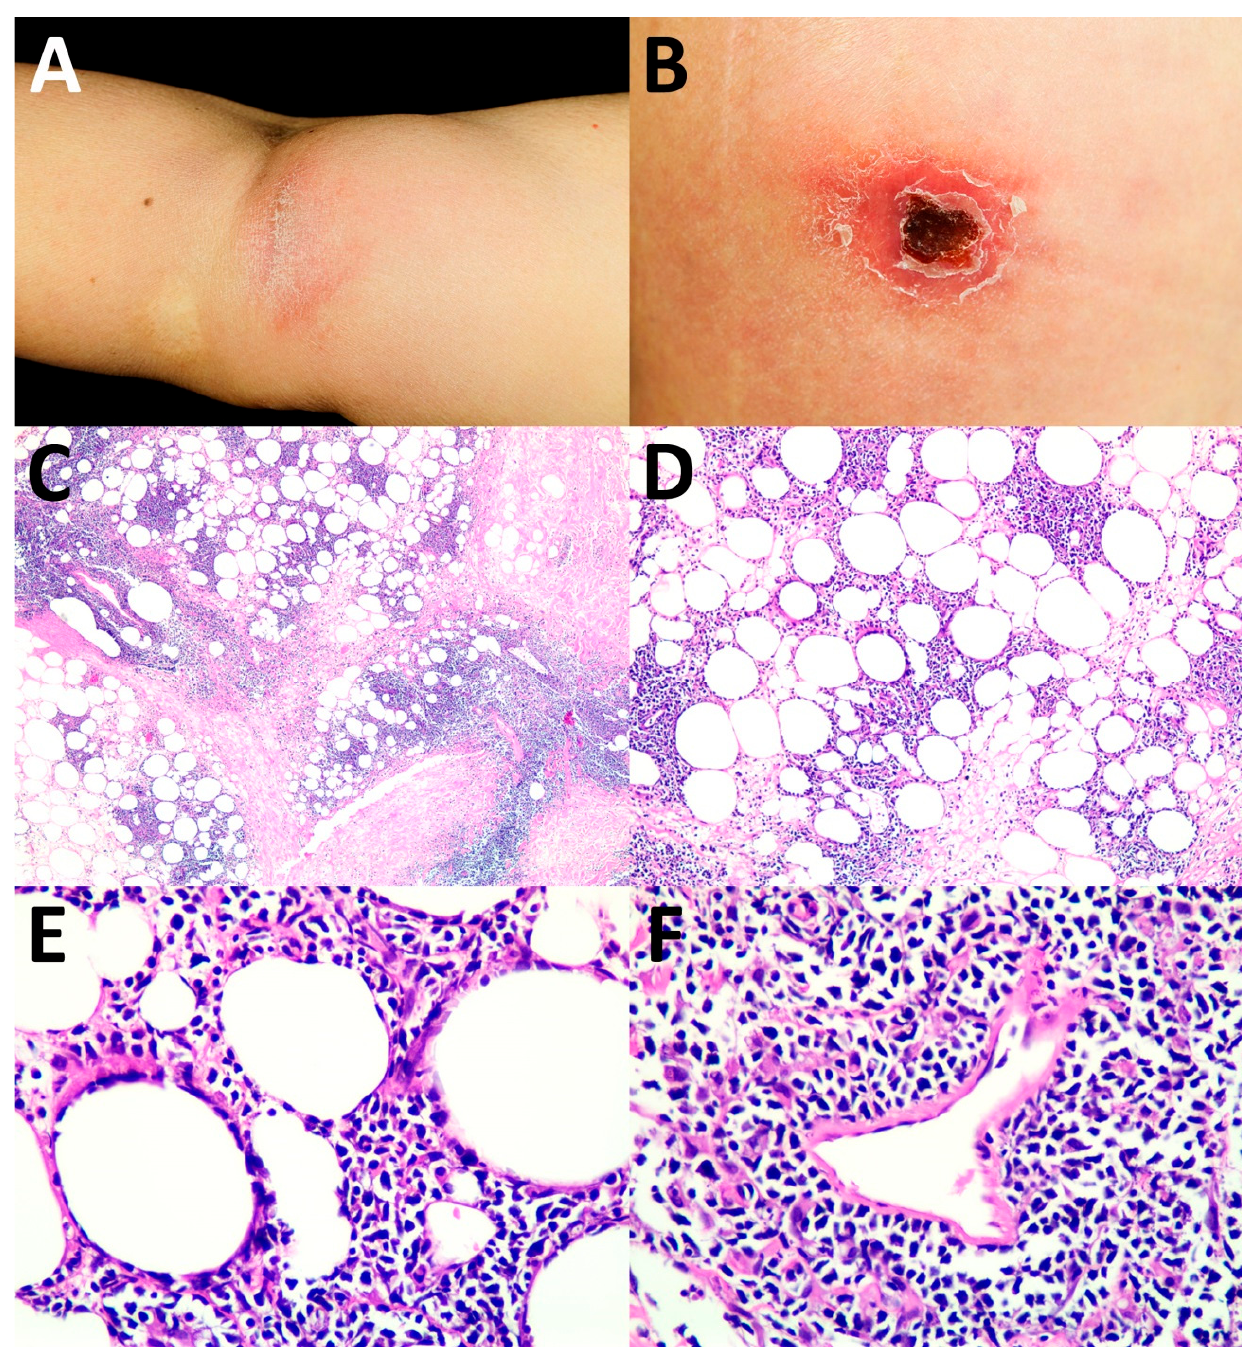
Figure 2. Lobular panniculitis pattern: ( A ) erythematous plaque and nodule without ulceration on right arm; ( B ) erythematous nodule with ulceration; ( C ) lobular infiltration by lymphoid cells (H&E, original magnification ×40); ( D , E ) periadipocytic rimming by atypical small-to-medium lymphoid cells (H&E, original magnification ×100 and ×400, respectively); ( F ) angioinvasion by atypical lymphoid cells (H&E, original magnification ×400).